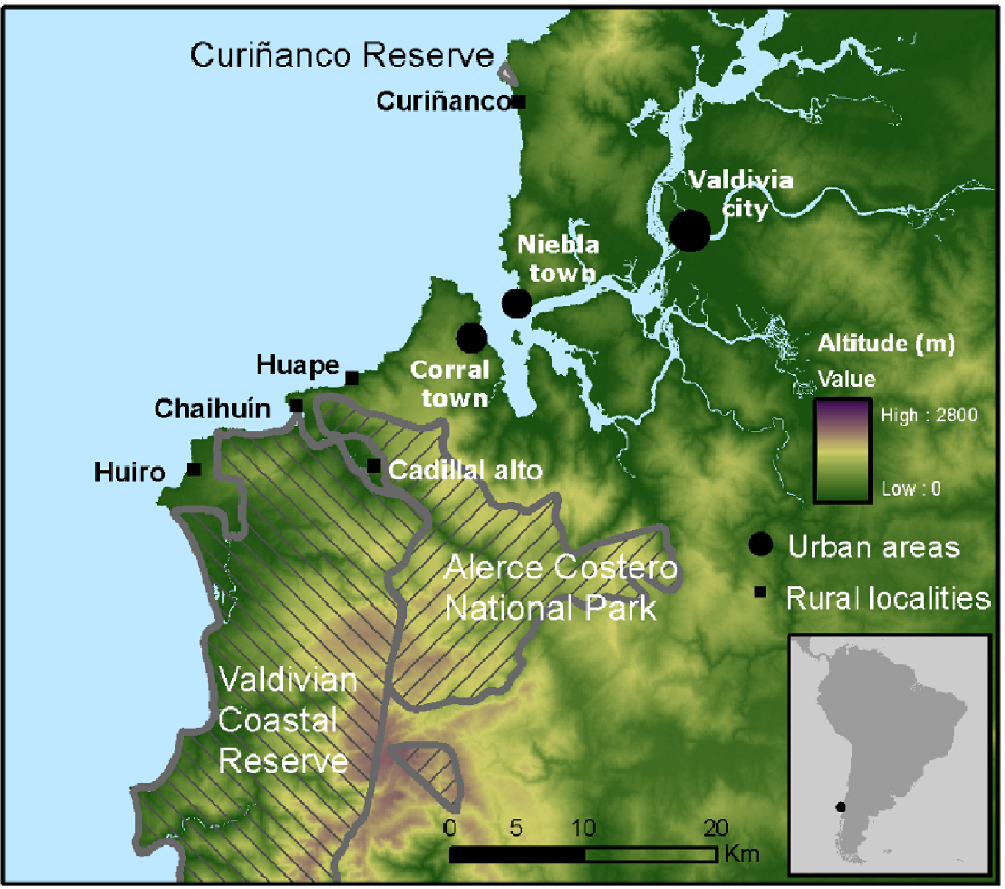
Figure 1. Map of the study area in the Coastal Range of southern Chile.